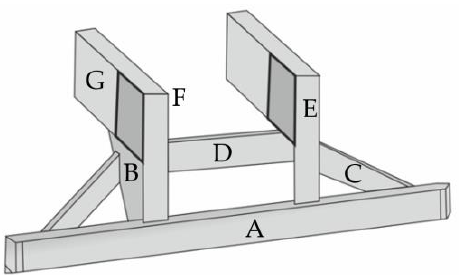
Figure 3. Hinged rear underrun protective device. A — cross-bar (guard bar), B — vertical supports (side surface), C — horizontal force supports, D — cross member, E — vertical force supports (end face), F — hinge, G — vehicle frame.